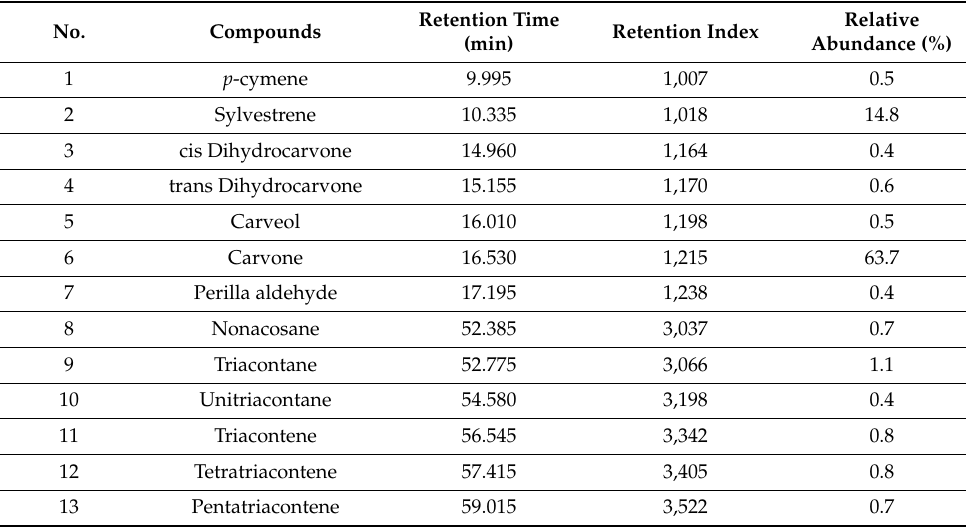
Table 1. Essential oil composition of C. carvi fruits using GC-MS